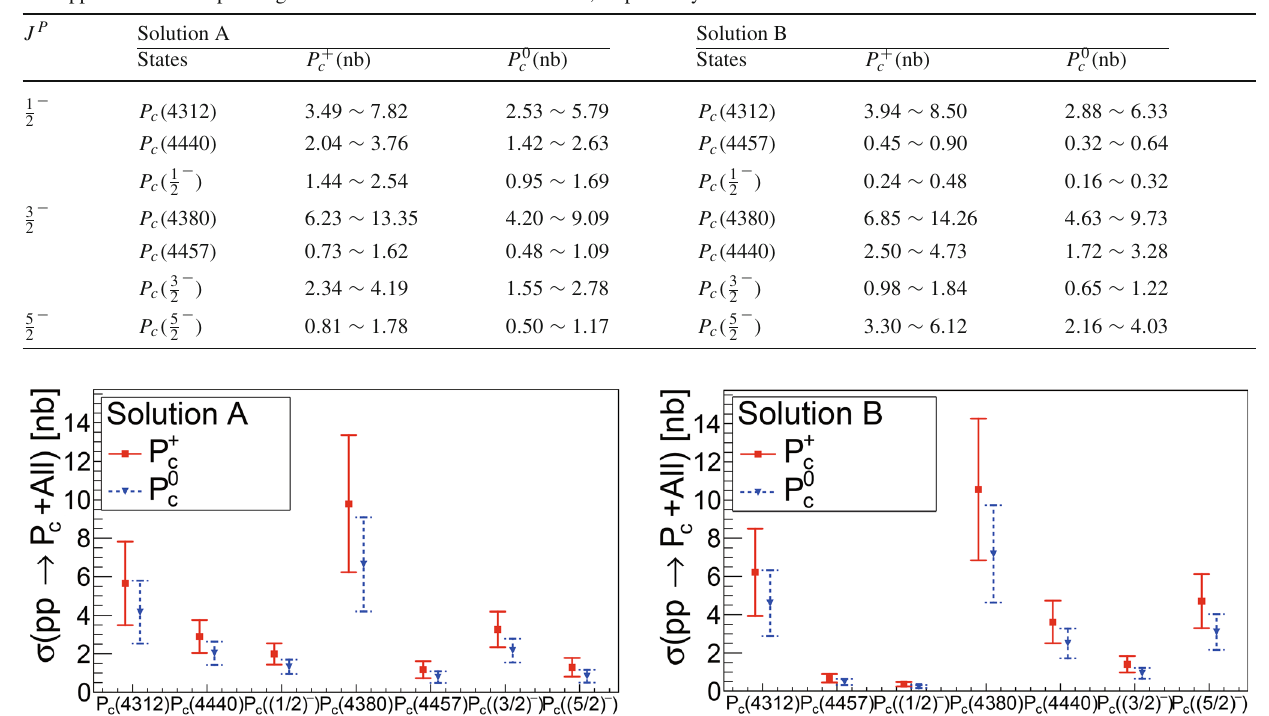
Table 1 The estimate of the inclusive cross section of hidden charm pentaquark states P + c s and P 0 c s in pp collision at and upper limits corresponding to (cid:5) = 0 . 7 GeV and (cid:5) = 1 . 3 GeV, respectively